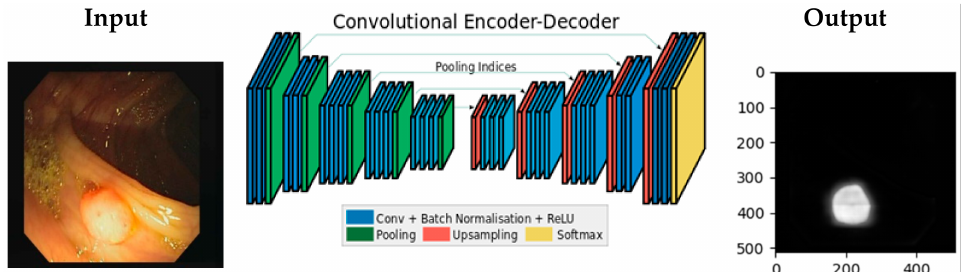
Figure 3. Convolutional encoder-decoder